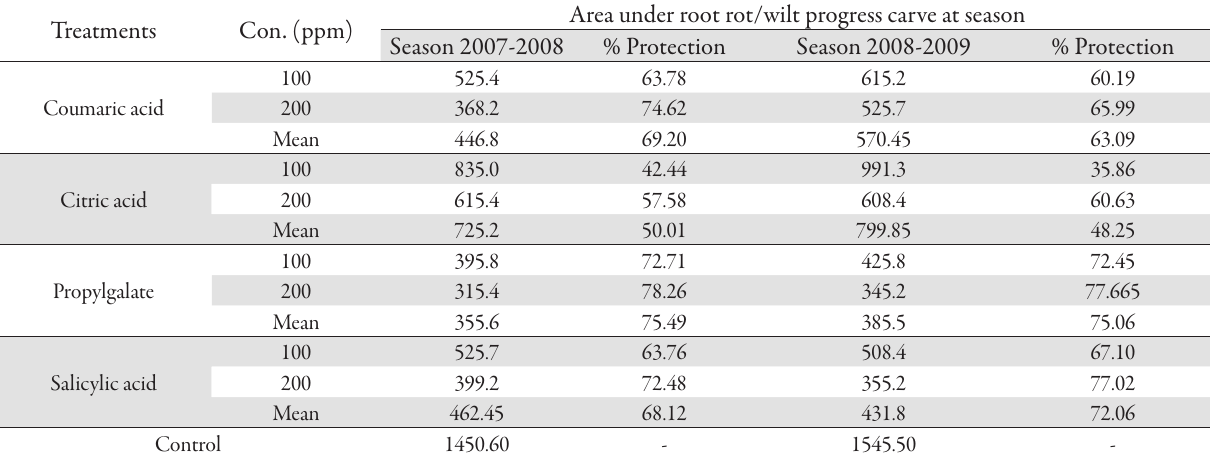
Tab. 8. Effect of soil drenching with antioxidant solutions on area under root rot/wilt progress curve during 2007-2008 and 2008- 2009 growing seasons under field conditions at New Valley,